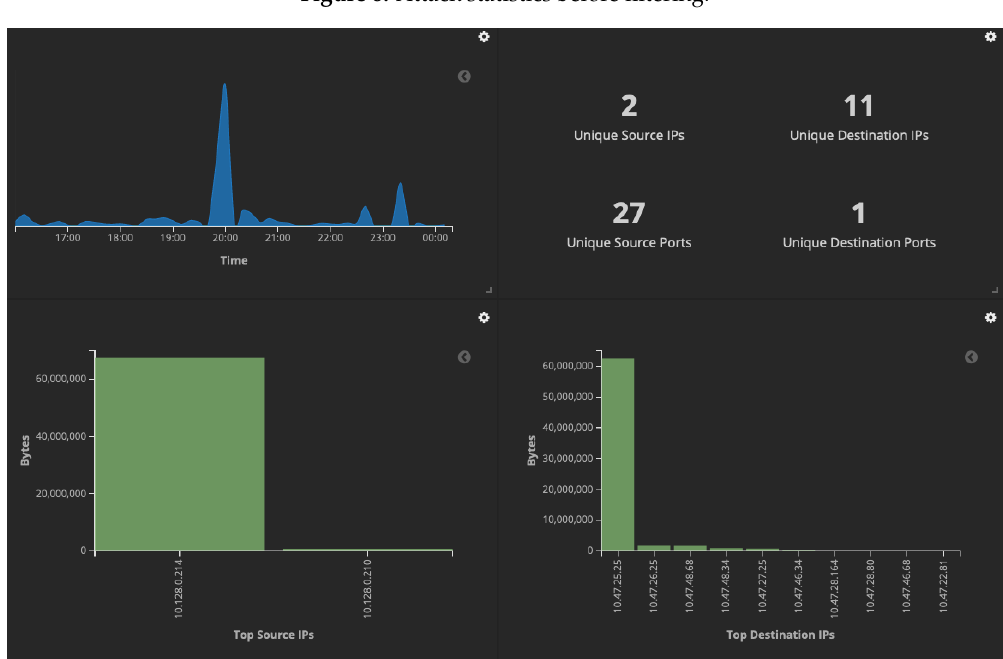
Figure 9. Attack statistics after